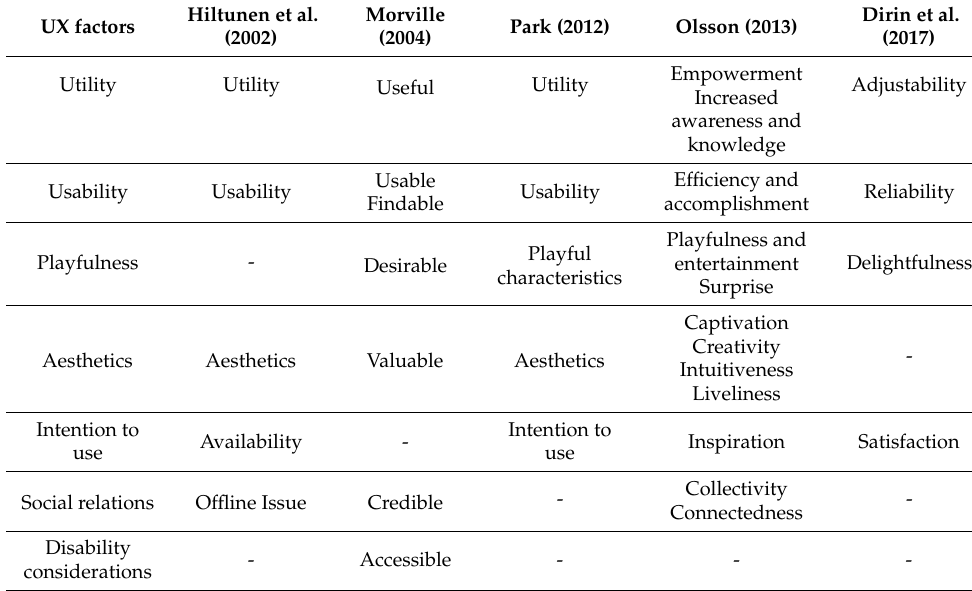
Table 1. User experience evaluation